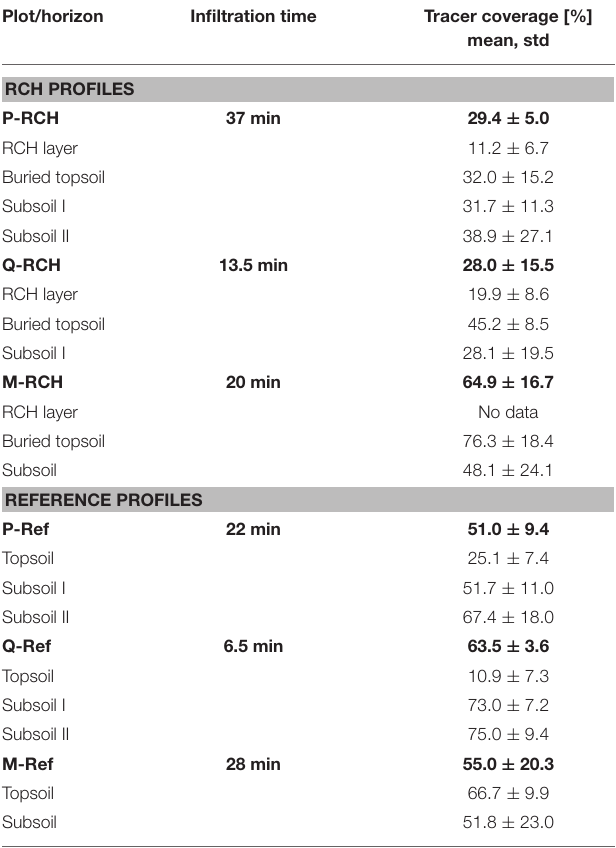
TABLE 2 | Infiltration times for the six plots and relative tracer coverage integrated over a profile depth of 1m (bold numbers), and over the specific horizons of each